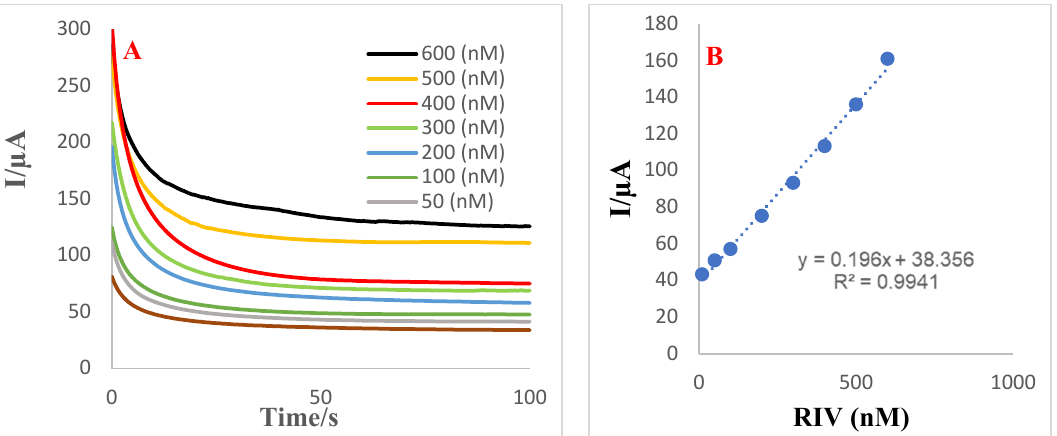
Figure 3. ( A ) ChAs of the engineered aptasensor in different concentrations of Riv (50 nM to 600 nM) in unprocessed human plasma samples. ( B ) Relationship between I pa and Riv concentration in plasma sample. t eq = 2, where E being = − 1 V, E end = 1 V, E step = 0.1 V, amplitude = 0.001 V, and frequency = 10 Hz. Using [Fe(CN) 6 ] 3 − /4 − /KCl (0.01 M) as the supporting electrolyte (n = 3).